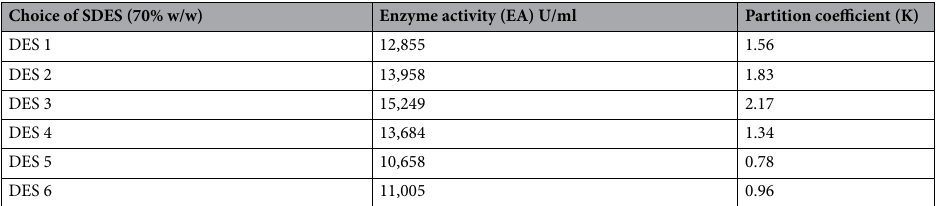
Table 3. Selectivity of SDES determined with their corresponding partition coefficient and enzyme activity. DES 1—TX: CCL, DES 2—TX: TBAB, DES 3—TX: TBAC, DES 4—TW: CCL, DES 5—TW: TBAB, DES 6— TW: TBAC. Relative uncertainty for the enzyme activity and partition coefficient are u r (EA) = 0.02 U/ml and u r (K) = 0.2.